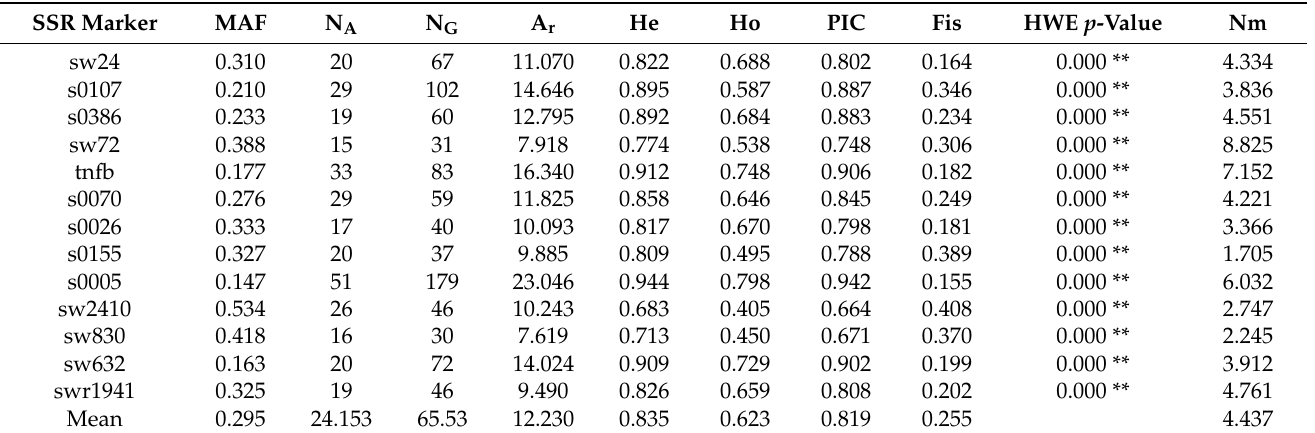
Table 2. Microsatellite diversity and polymorphism by